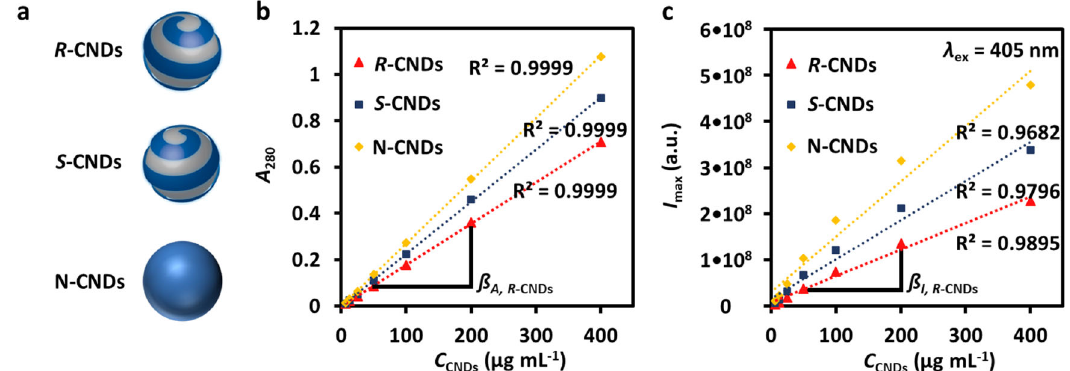
Fig. 1 Carbon nanodots concentration determination through UV-Vis and fl uorescence emission spectrophotometry. a Sketch of the N - , S- , and R- CNDs. b Absorption A 280 at 280 nm of CNDs dissolved in water at the mass concentration C CNDs (determined by weighting). The A 280 ( C CNDs ) curve was fi tted with linear regression to yield the slope ß A , j (mL μ g – 1 ) = Δ A 280 ( j ) Δ C CNDs – 1 ( j = R- CND, S- CND, N - CND). R 2 indicates the fi tting reliability with linear regression (perfect fi t: R 2 = 1). Data for the absorption at 405 nm ( A 405 ) are shown in Supplementary Fig. 6. c Integrated fl uorescence emission I max ranging from 425 to 475 nm (excitation wavelength λ ex = 405 nm) of CNDs dissolved in water at the mass concentration C CNDs . The I max ( C CNDs ) curve was fi tted with linear regression to yield the slope ß I , j (mL μ g – 1 ) = Δ I max ( j ) Δ C CNDs – 1 ( j = R- CND, S- CND, N - CND). From these slopes, fi rst the percentual differences Δ ß i , j in the slopes between the R- CND and S- CND sample to the N - CND sample were derived for the absorption and intensity measurements as Δ ß i , j = (ß i ,N - CND − ß i , j ) ß i ,N - CND – 1 ( i = A , I ; j = R- CND, S- CND), and then the deviation Δ ß j in these differences between the absorption and intensity measurements were obtained as Δ ß j = | Δ ß A , j − Δ ß I , j | ( j = R- CND, S- CND). The percentual error in concentration determination was de fi ned as